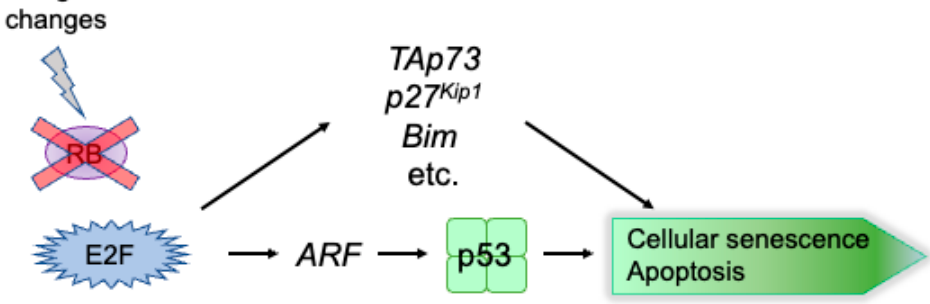
Figure 5. Multiple pathways for E2F-mediated tumor suppression. Deregulated E2F induces cellular senescence or apoptosis through multiple pathways. One is mediated through p53 by activating the tumor suppressor gene ARF . Others are mediated through TAp73 , Bim , and other tumor suppressor genes. Many cancer cells survive by dysfunction of the ARF-p53 pathway, despite the presence of other tumor suppressive pathways.